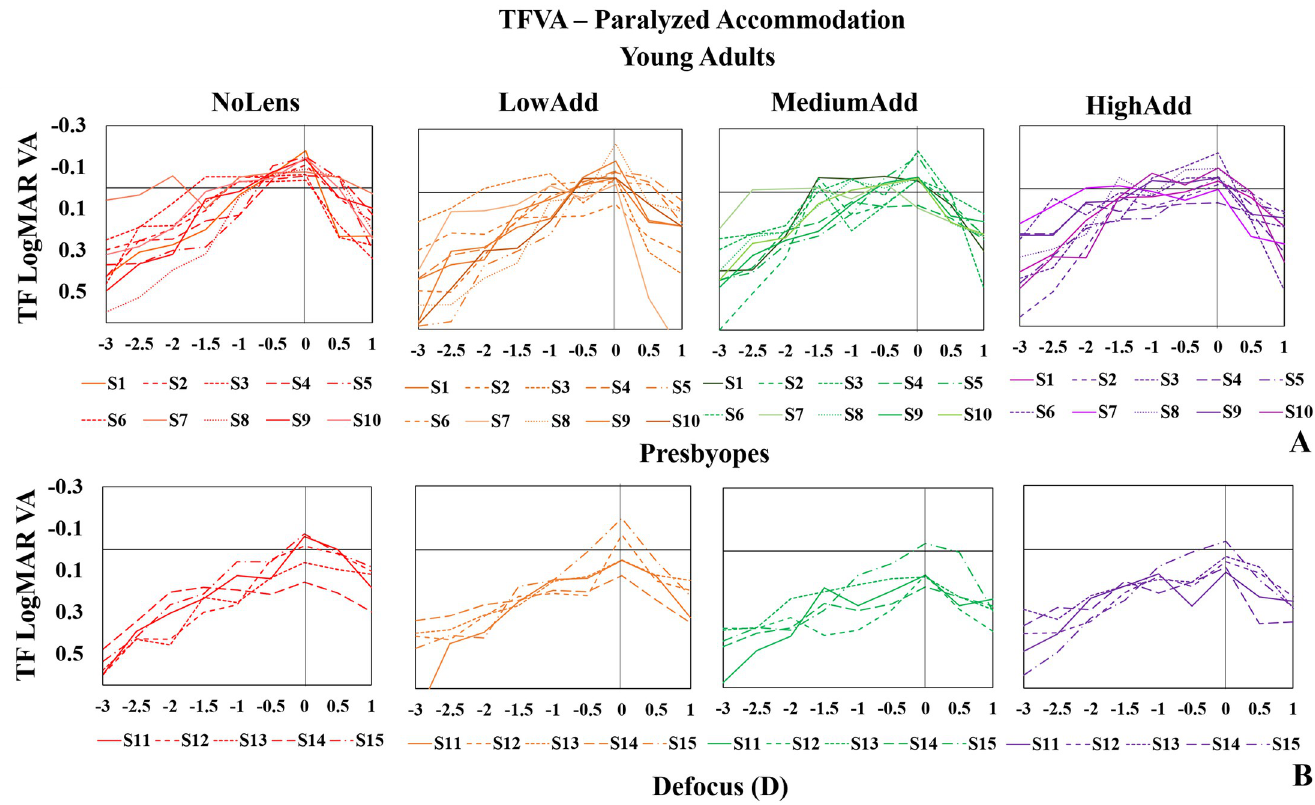
Fig 3. TFVA data shown for all subjects and conditions under paralyzed accommodation with 5 mm pupil diameters. (A) young adults (top panels); (B) presbyopes (bottom panels). Conditions from left to right are NoLens, LowAdd, MediumAdd, HighAdd. Lens condition identified by color—Red: NoLens; Orange: LowAdd; Green: MediumAdd; Purple: